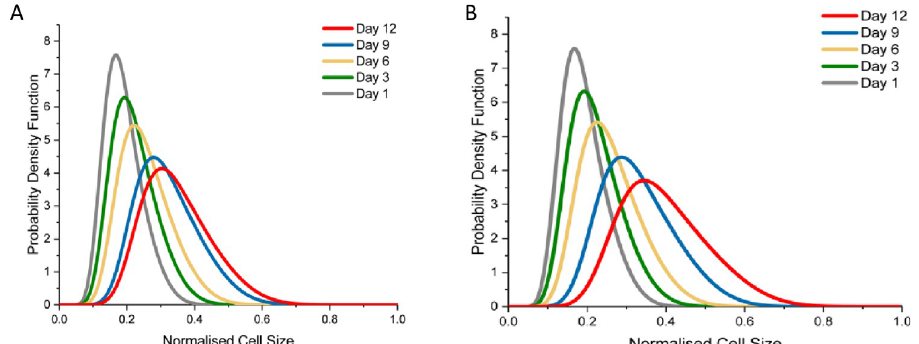
Fig 2. Normalised cell distribution for the physiological temperature (A) and mild hypothermic cultures (B). The cell diameters were taken from the NucleoCunter ™ and the given distributions are obtained from distribution fitting in MATLAB.